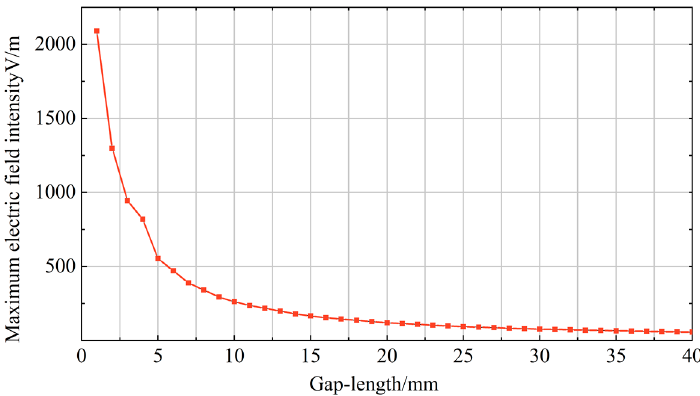
Figure 6. Electric field intensity change curve.